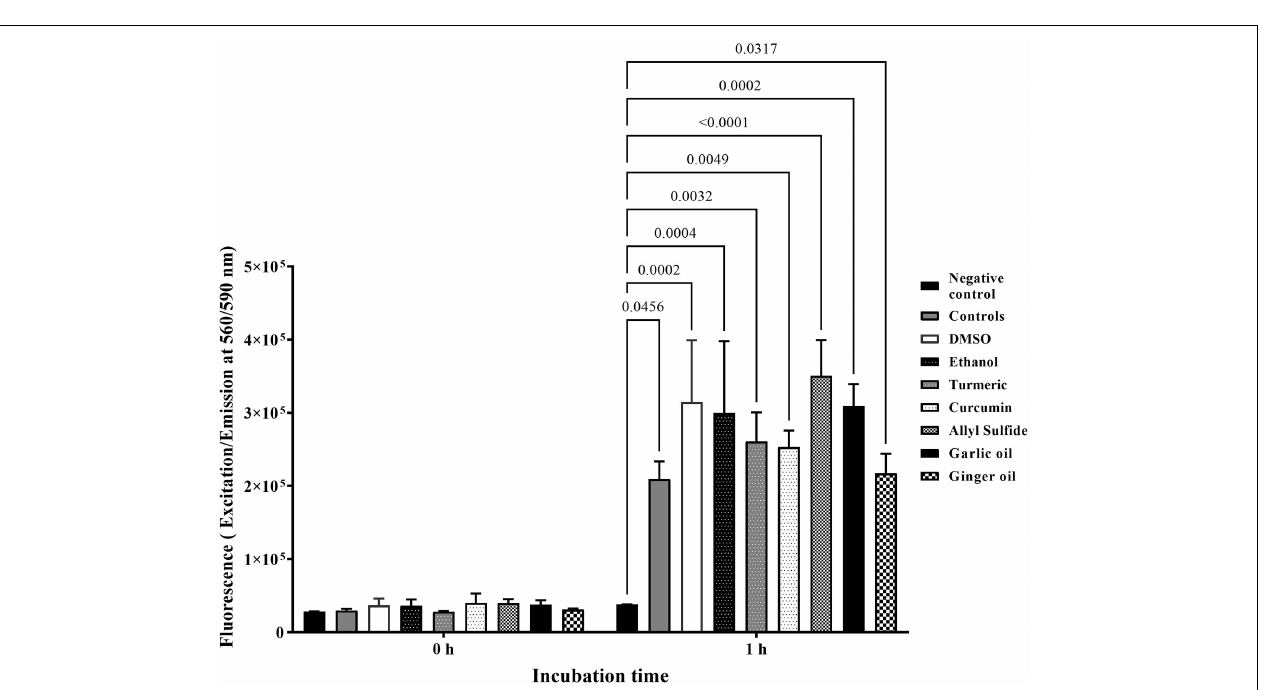
FIGURE 3 | Determination of SIC of DMSO (A) , ethanol (B) , turmeric (C) , curcumin (D) , allyl sulfide (E) , garlic oil (F) , and ginger oil (G) against C. jejuni S-8 in a microtiter plate. Results are averages of three independent experiments, each containing duplicate samples (mean and SEM). *Indicates a significant difference between control and treatment.